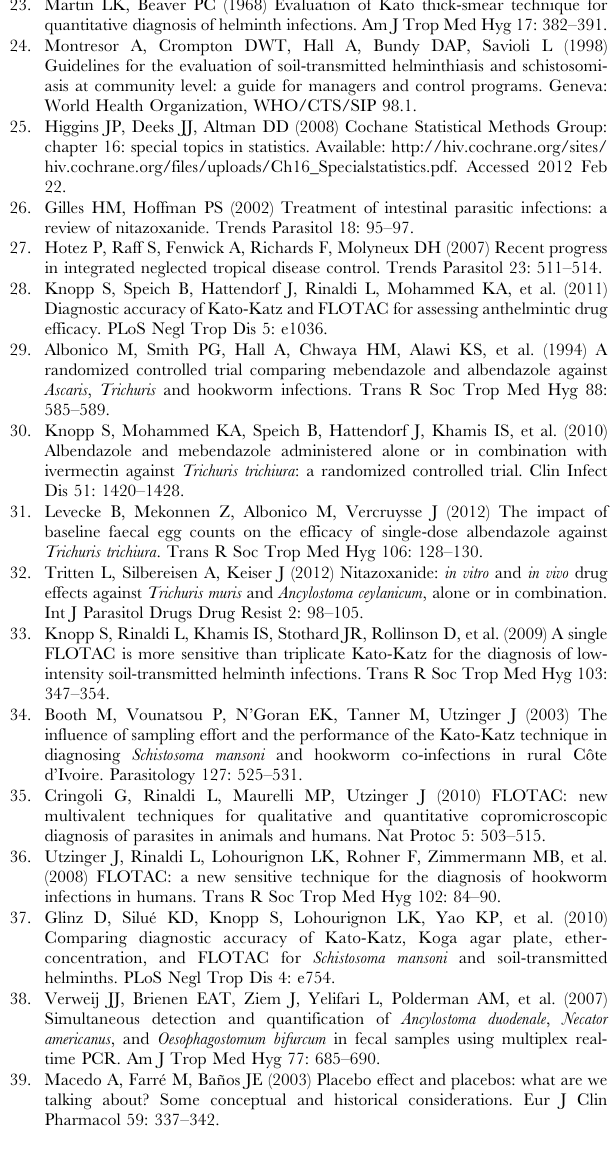
Table S2 Number of specific adverse events assessed at different time points.